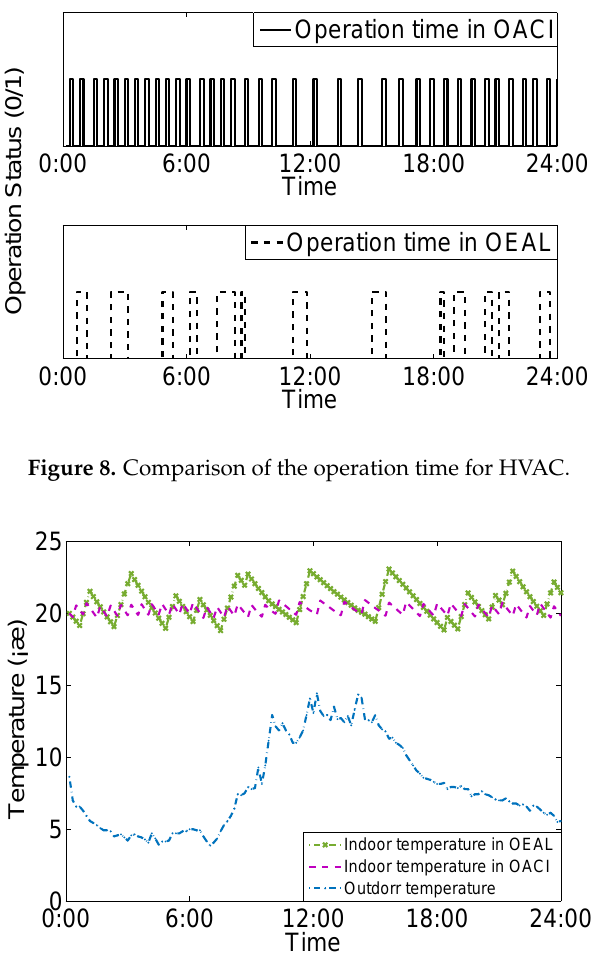
Figure 9. Comparison of the indoor temperature for